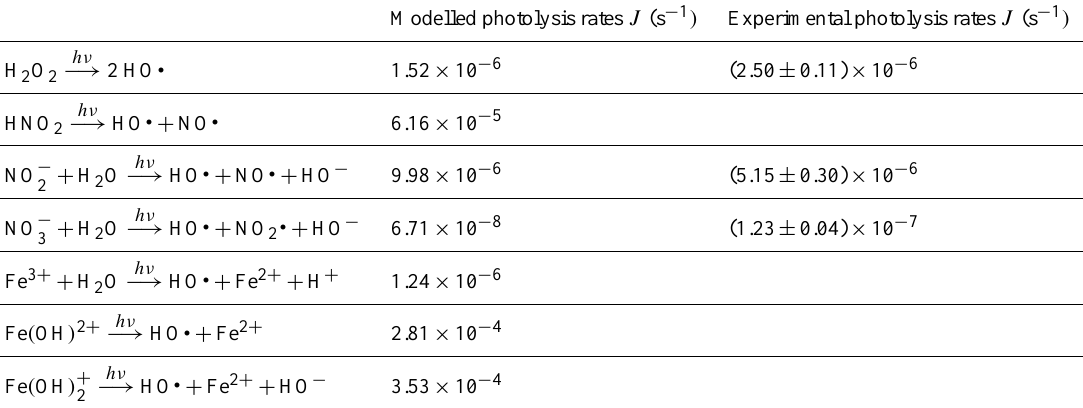
(cid:113) ) found in the literature and in this work. HO